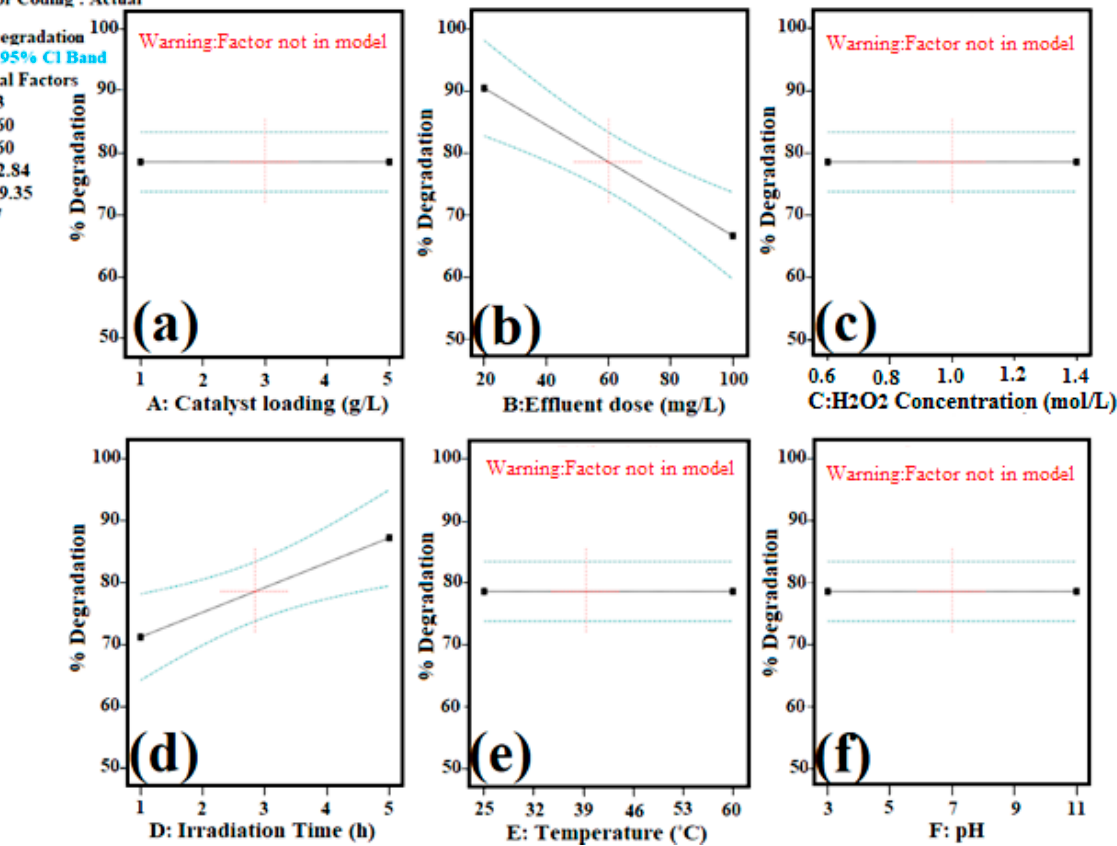
Figure 4. Main effect plot % degradation vs. process variable: ( a ) catalyst loading; ( b ) ORG concen- tration; ( c ) H 2 O 2 concentration; ( d ) Time of irradiation; ( e ) Temperature; and ( f )